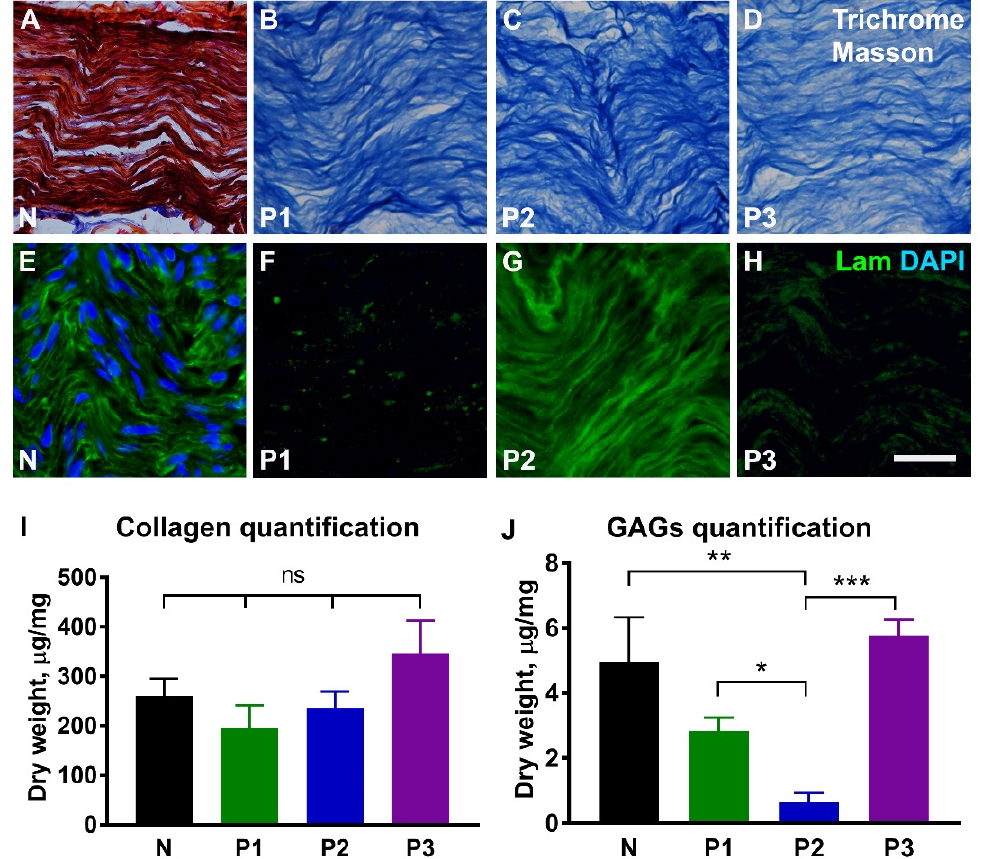
Figure 3. Extracellular matrix in the decellularized nerve tissue. Representative longitudinal sec- tions from normal nerve (N) and decellularized nerves following treatment with protocols P1, P2, and P3, and stained for collagen ( A – D ) and laminin ( E – H ). The red colour in ( A ) corresponds to the cell cytoplasm in normal nerve. Histograms in ( I , J ) show quantitative analysis of insoluble fibrillary collagen ( n = 5) and sulfated glycosaminoglycans (GAGs, n = 5). Note strong laminin immunostaining following treatment with P2 protocol. Error bars show the S.E.M. p -values are indicated as follows: * p ≤ 0.05, ** p ≤ 0.01, and *** p ≤ 0.001; ns, not significantly different. Scale bar, 25 µm.